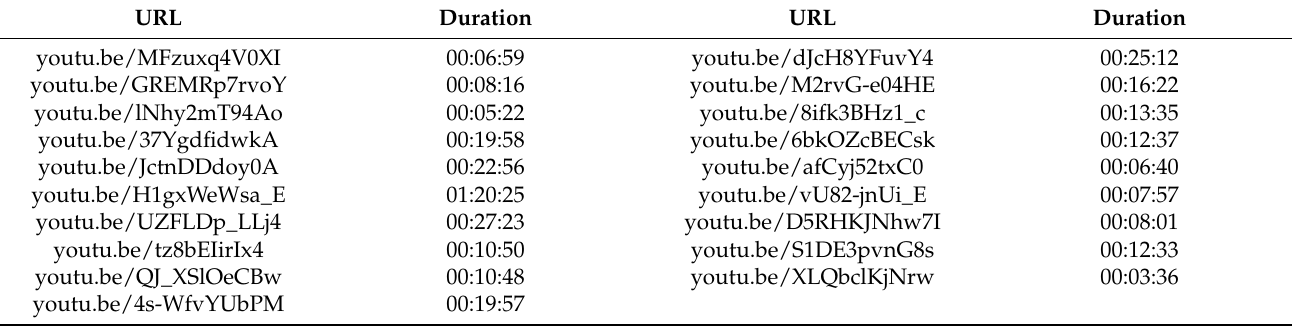
Table 1. Sources of the videos used for the preparation of the